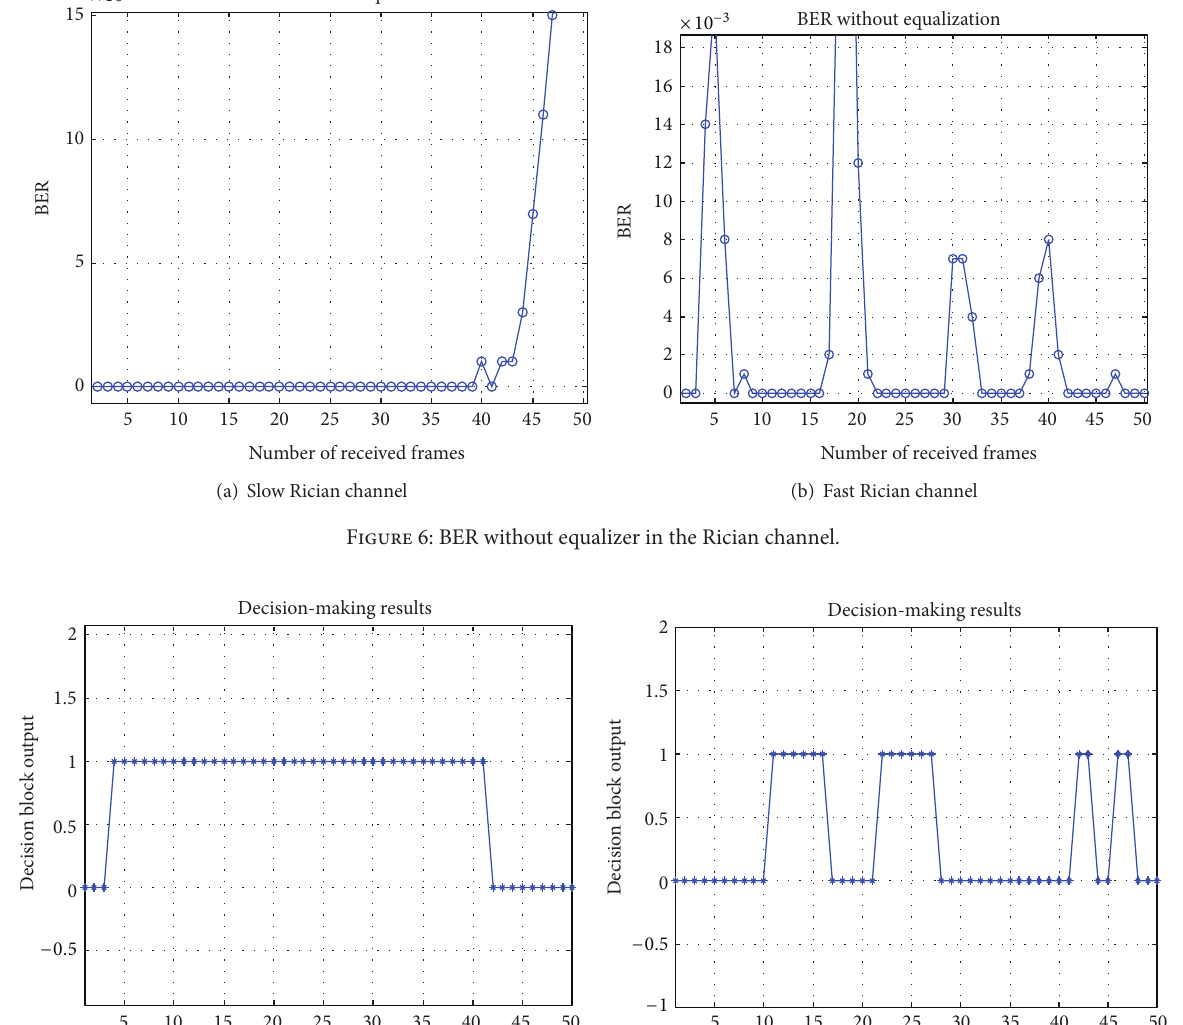
equalizer off, “0” equalizer → →